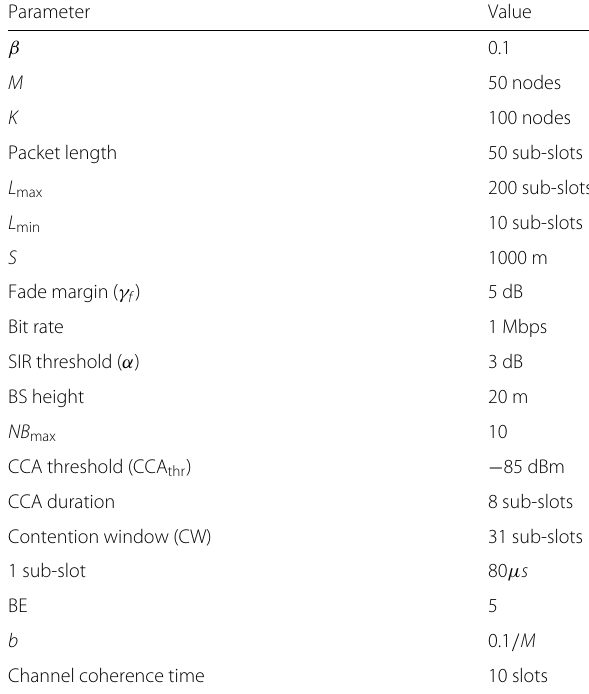
Table 1 Default simulation